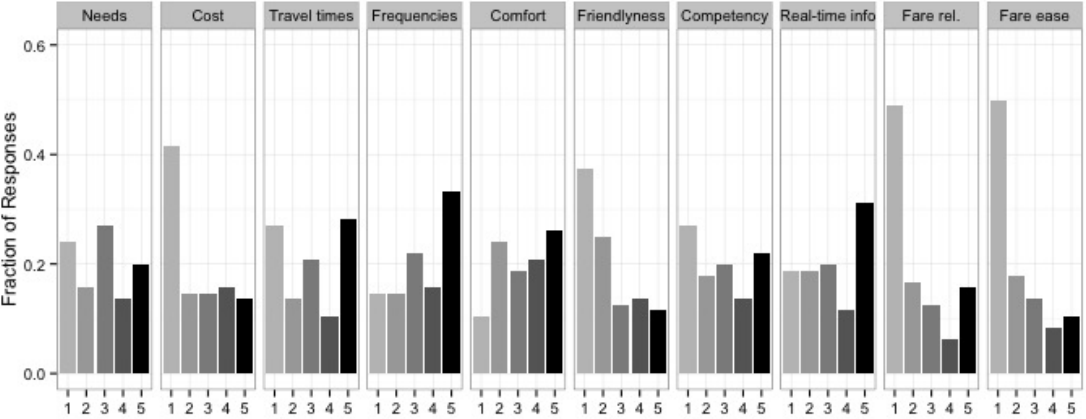
Figure 4. Stated reasons for wanting to use transit less or not at all